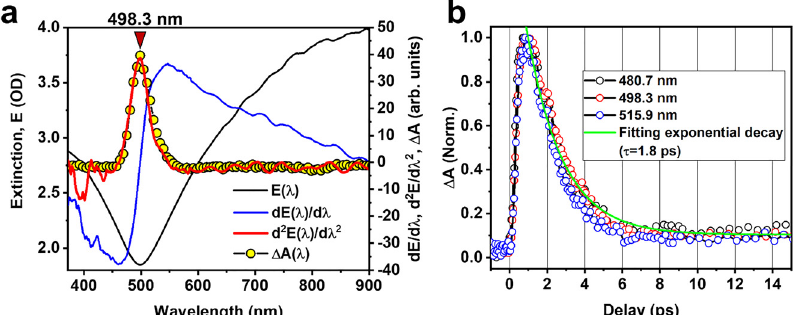
Figure 5: (a) Optical extinction (solid black) andTA(opencircles)spectrameasuredona gold film with a thickness of about 130 nm, and the calculated fi rst- (sold blue) and second-order (solid red) differentials of the optical extinction spectrum, showing per- fect agreement of Δ A with d 2 E /d λ 2 . (b) Normalized TA dynamics at 480.7, 498.3, and 515.9